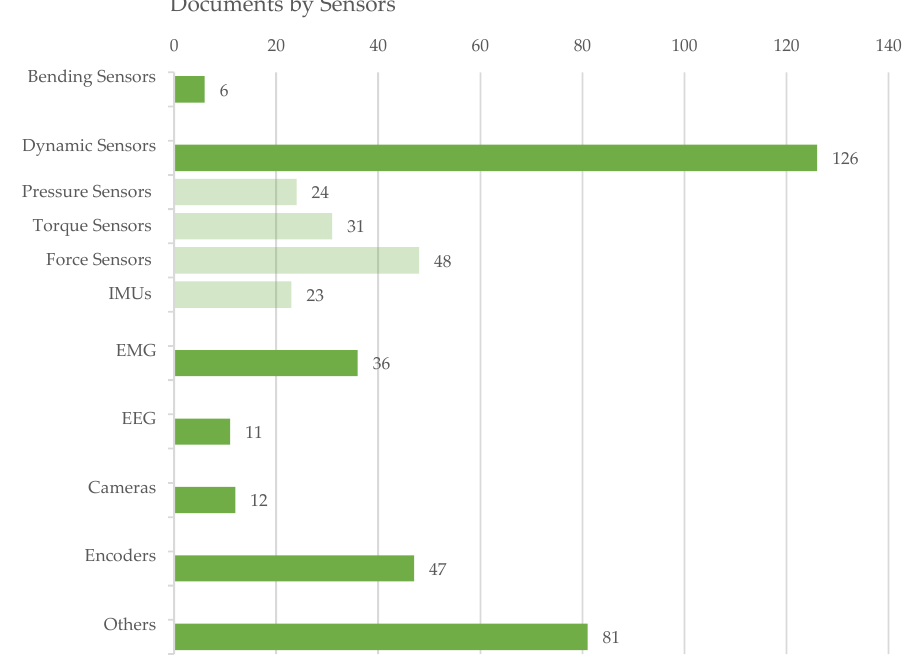
Figure 18. The distribution of exoskeletons by sensors. In the sensors for exoskeletons context dynamic sensors are predominant (40%), with a significant number of force and torque sensors. Encoders are also quite diffused (14%). The Other class has a relevant weight (25%), because a wide range of different other types of sensors are used within